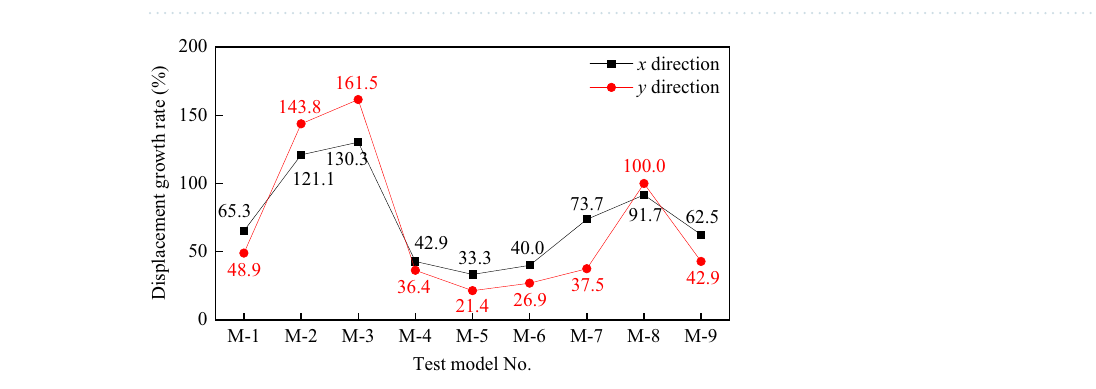
Figure 15. Time-history of displacement at the top of pier model M-1 under different PGAs, ( a ) down-bridge direction, ( b ) cross-bridge direction.